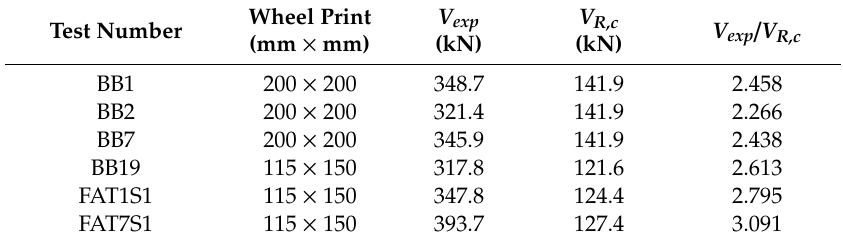
Table 5. Comparison between the mean predicted punching capacity and punching capacity in experiment.